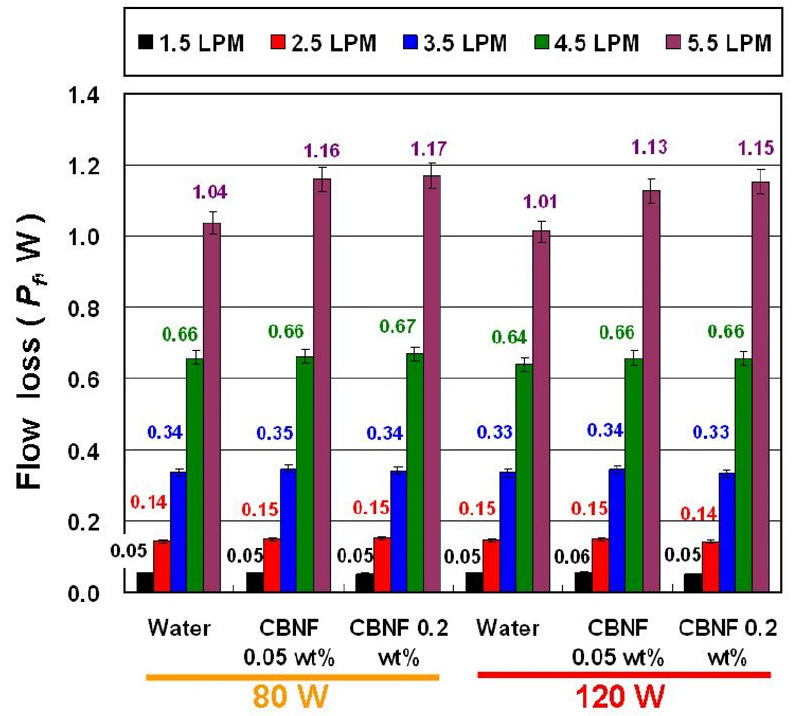
Figure 5. The P f of test samples for THE at various experimental parameters.